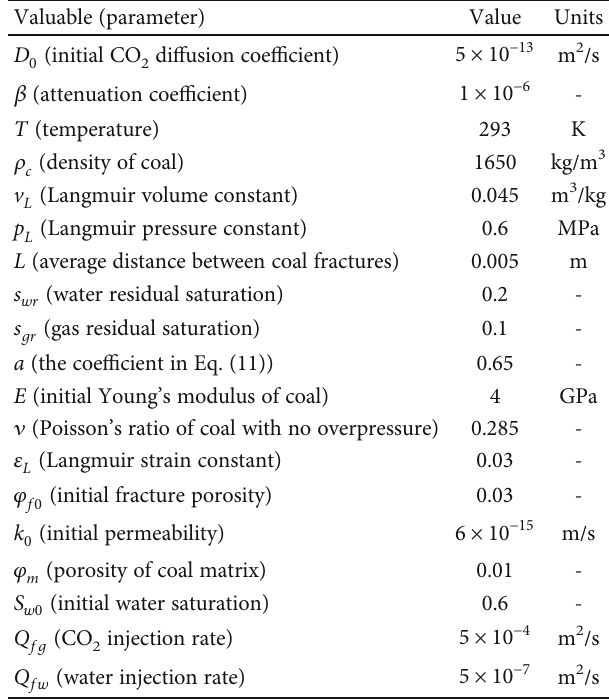
Table 1: Parameters implemented in the